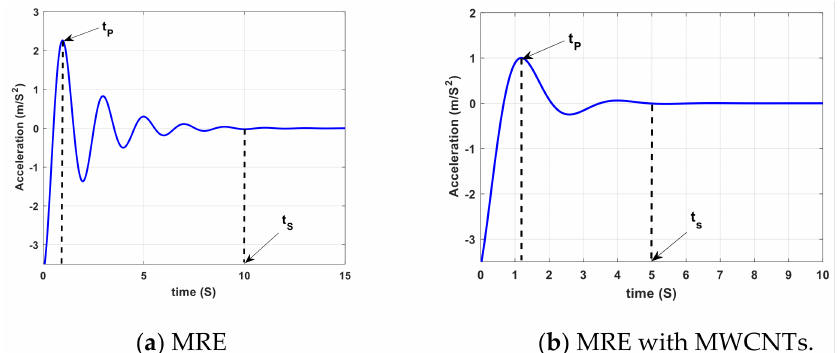
Figure 16. The effect of suppressing acceleration between two